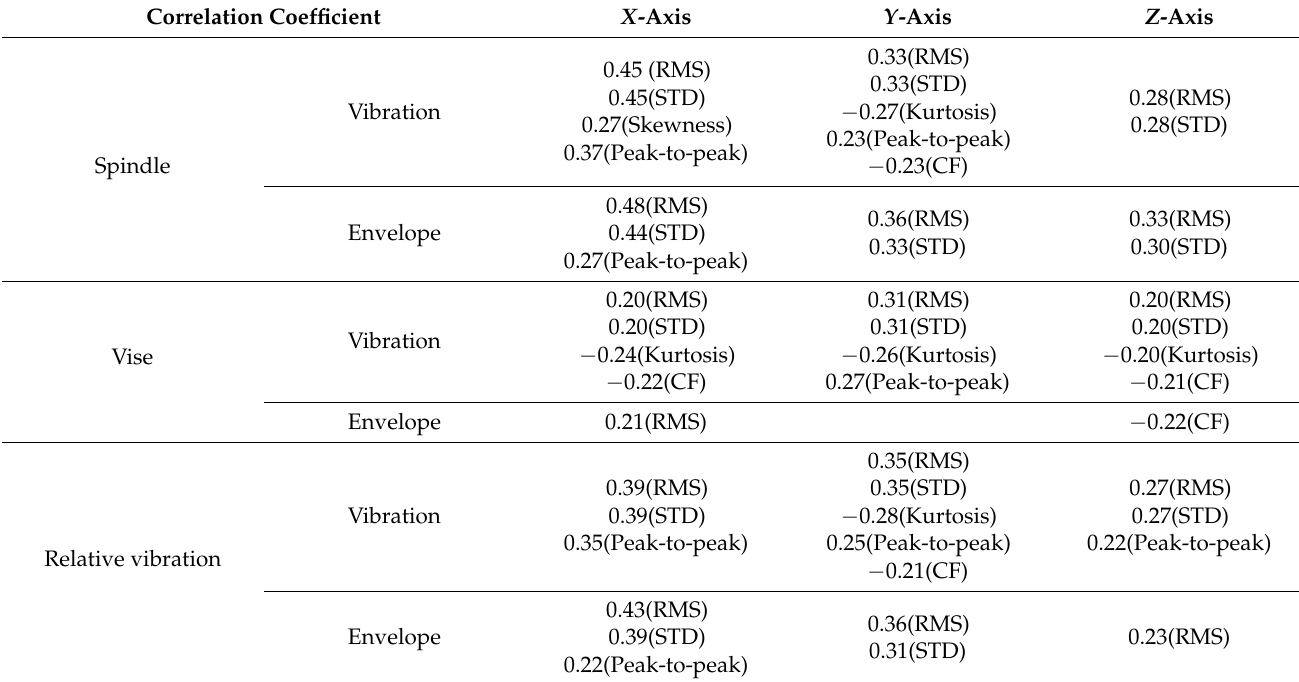
Table 4. Pearson correlation coefficients (absolute value ≥ 0.2) between the vibration statistical features and the Ra values. Correlation Coefficient